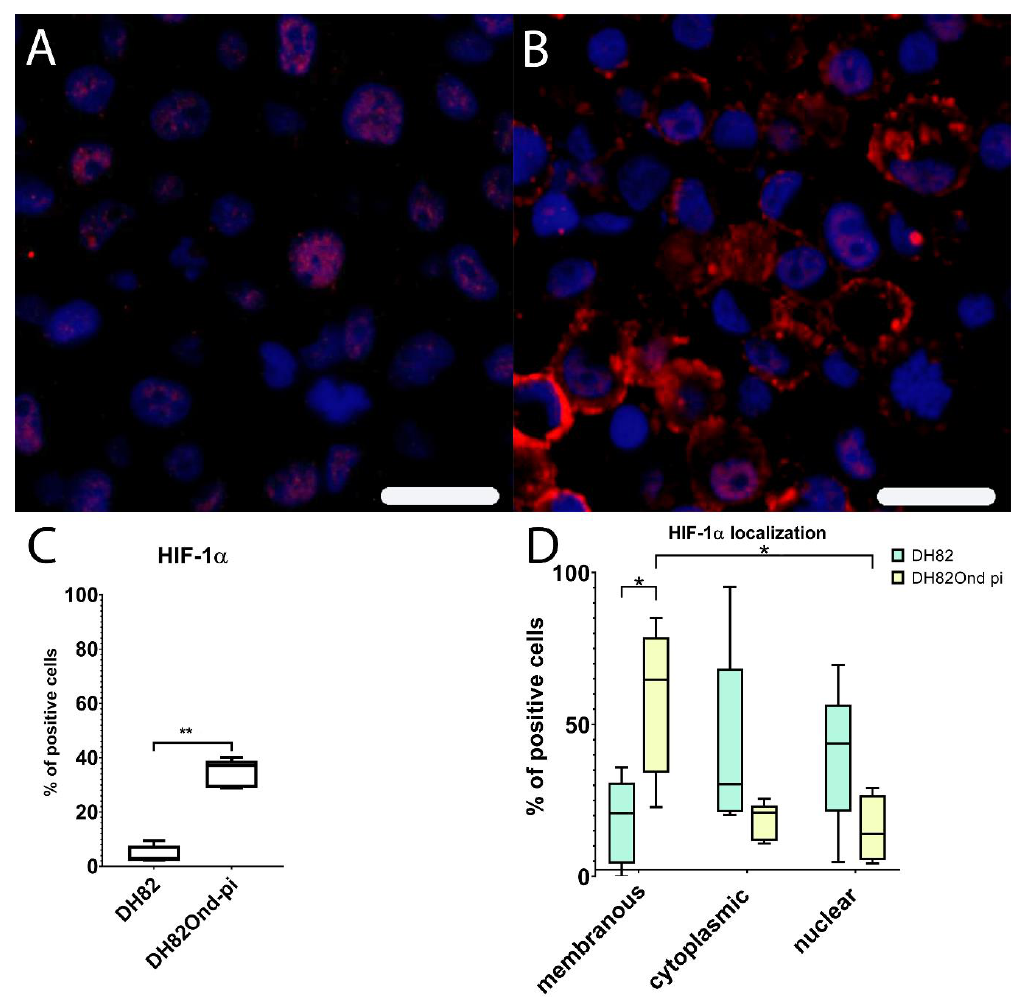
Figure 3. Immunofluorescence analysis for HIF-1 α expression (Cy3, red; bisbenzimide, blue, nuclei) reveals a lower membranous expression in non-infected ( A ) compared to persistently canine distemper virus (CDV) infected ( B ) DH82 cells. Non-infected DH82 cells frequently displayed a nuclear immunolabeling ( A ) whereas a frequent membrane-associated staining was observed in persistently CDV-infected DH82 cells ( B ). Bar = 20 µ m. HIF-1 α shows a significantly increased percentage of positive cells in persistently CDV-infected DH82 cells compared to non-infected controls ( C ). ( D ) Within non-infected DH82 cells, HIF-1 α was present within nucleus and cytoplasm without significant di ff erences between the localizations. In contrast, persistently CDV-infected DH82 cells displayed a significantly higher membranous HIF-1 α expression compared to nuclear ( p = 0.0486) but not to cytoplasmic ( p = 0.0710) localizations. Additionally, the membranous immunopositivity for HIF-1 α in persistently CDV-Ond infected DH82 cells was significantly higher compared to the corresponding localization in non-infected controls. Box and whisker plots display median and quartiles with maximum and minimum values. Significant di ff erences ( p ≤ 0.05, Mann–Whitney U-test ( C,D ) and Kruskall-Wallis test with post-hoc Dunn’s test ( D )) are labeled by asterisks (* p ≤ 0.05 and ** p ≤ 0.01). HIF-1 α immunoblotting confirmed the significantly increased protein expression ( p = 0.0027) in DH82Ond pi cells when compared to the non-infected DH82 cells (Figure